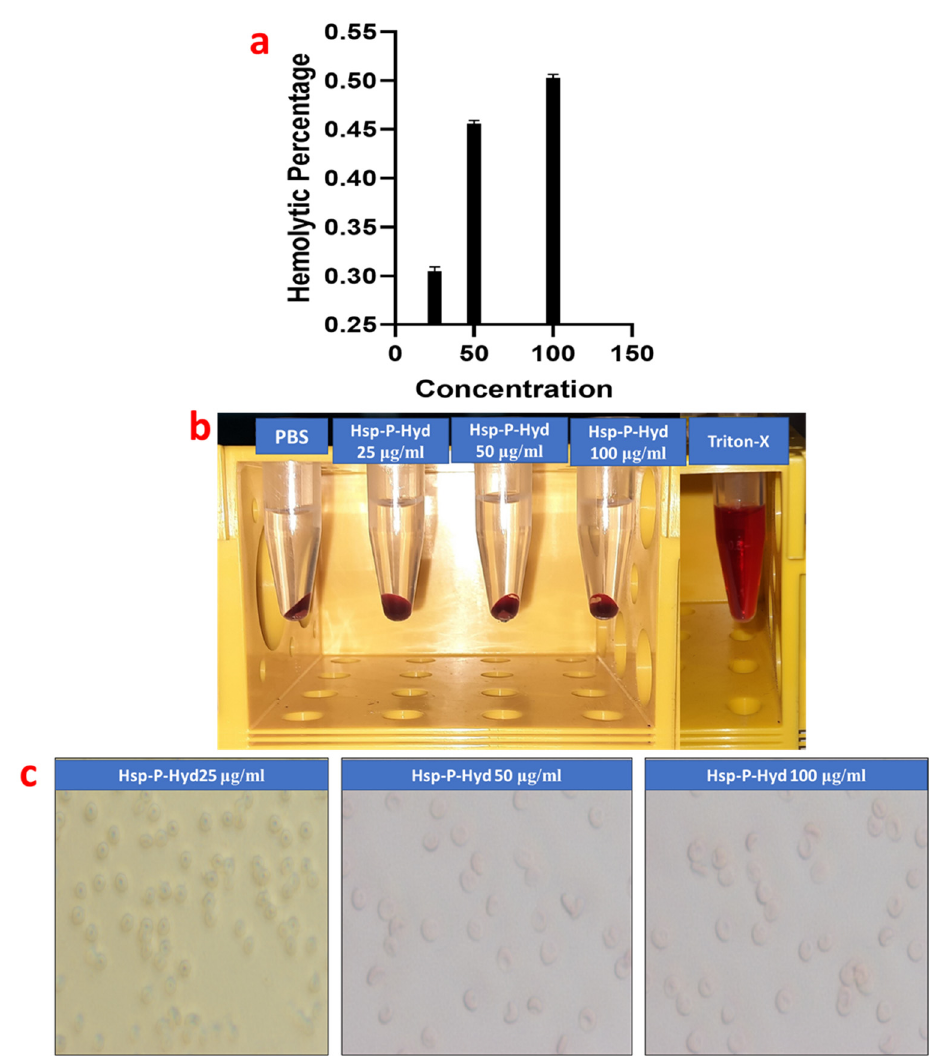
Figure 4. Representation of percentage hemolysis of ( a ) Hsp-PAMAM at concentration 25 μ g/mL, 50 μ g/mL, and 100 μ g/mL, ( b ) Representation of hemolysis using different concentrations of Hsp-PAMAM (left to right: Treated with Hsp-PAMAM at concentration 25 μ g/mL, 50 μ g/mL, and 100 μ g/mL, PBS and positive control), ( c ) Optical microscopic images of RBC treated with (i) 25 μ g/mL, (ii) 50 μ g/mL, and (iii) 100 μ g/mL of Hsp-PAMAM.